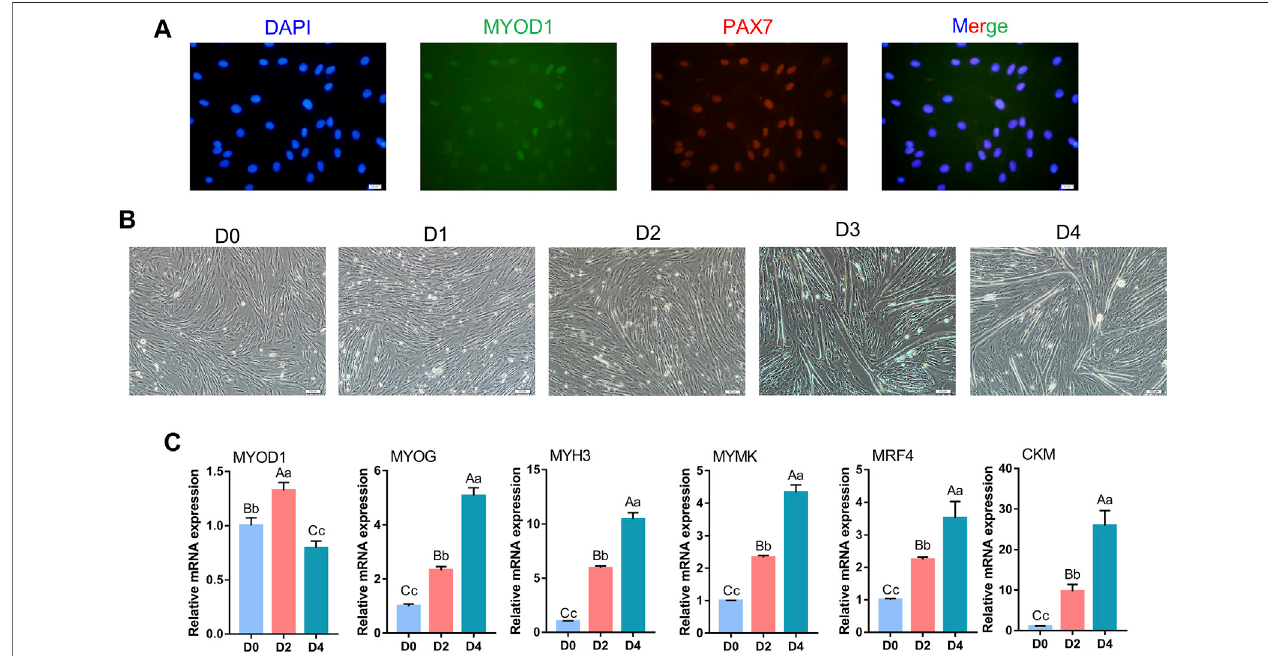
FIGURE 1 | Identi fi cation of bovine skeletal myoblasts. (A) Identi fi cation of myoblasts based on PAX7 and MYOD1 expression in growth medium (GM) (scale bar: 20 μ m). (B) Observation of myotube formation on days 0, 1, 2, 3 and 4 of culture in differentiation medium (DM) after the induced myogenic differentiation (scale